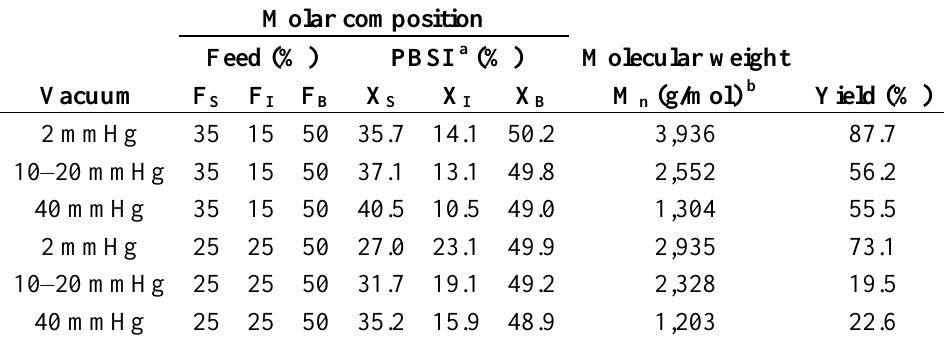
Table 3. The effect of vacuum on CALB-catalyzed synthesis of PBSI. Molar composition PBSI a (%) Molecular